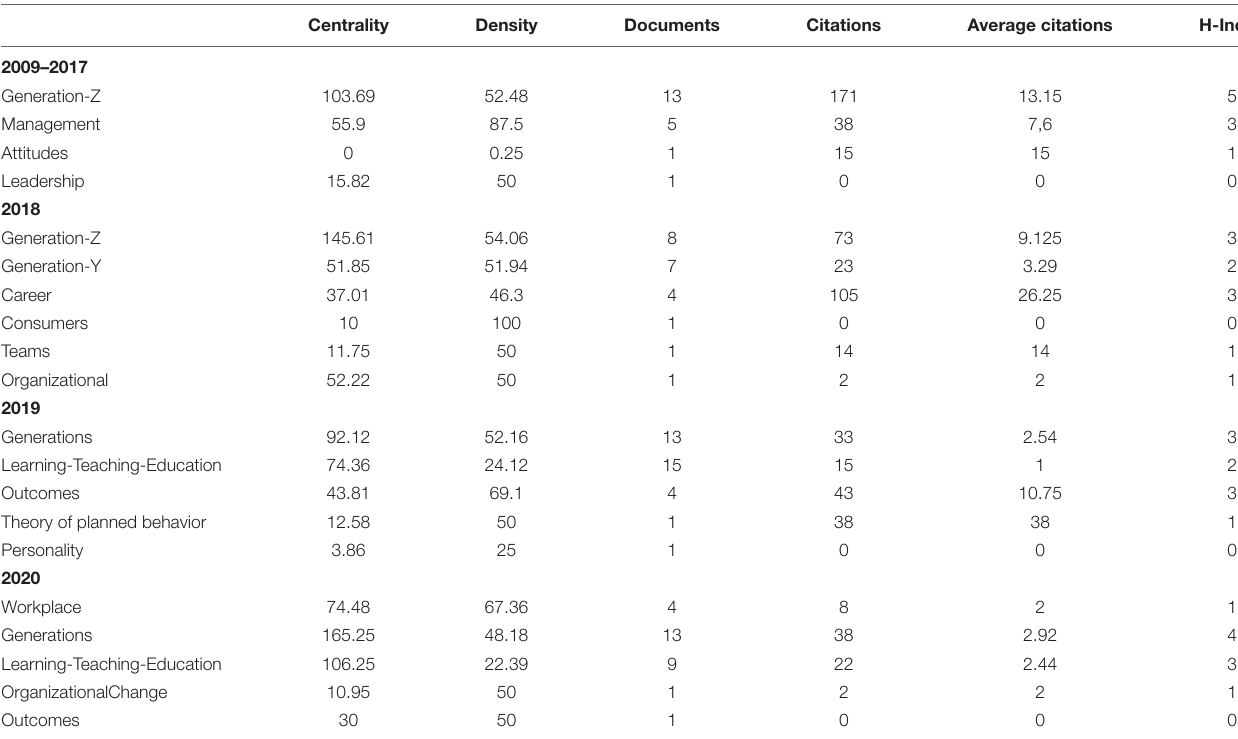
FIGURE 4 | Theme evolution of primary documents. Source: Elaborated with SciMAT. TABLE 5 | Quantitative factors of the themes and their